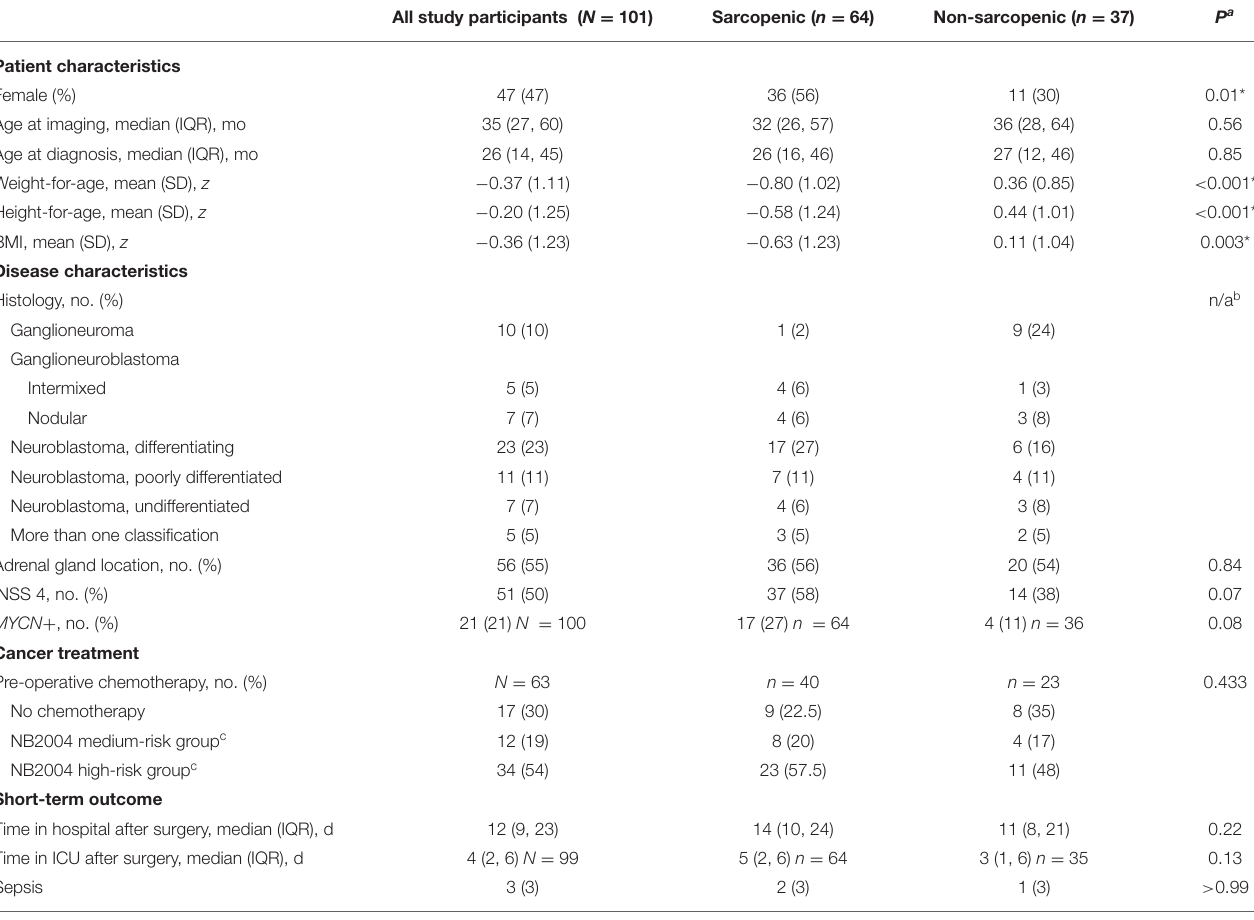
TABLE 1 | Comparison of pre-, intra-, and short-term post-operative data with sarcopenic status in whole cohort. All study participants ( N = 101) Sarcopenic ( n = 64) Non-sarcopenic ( n = 37) P